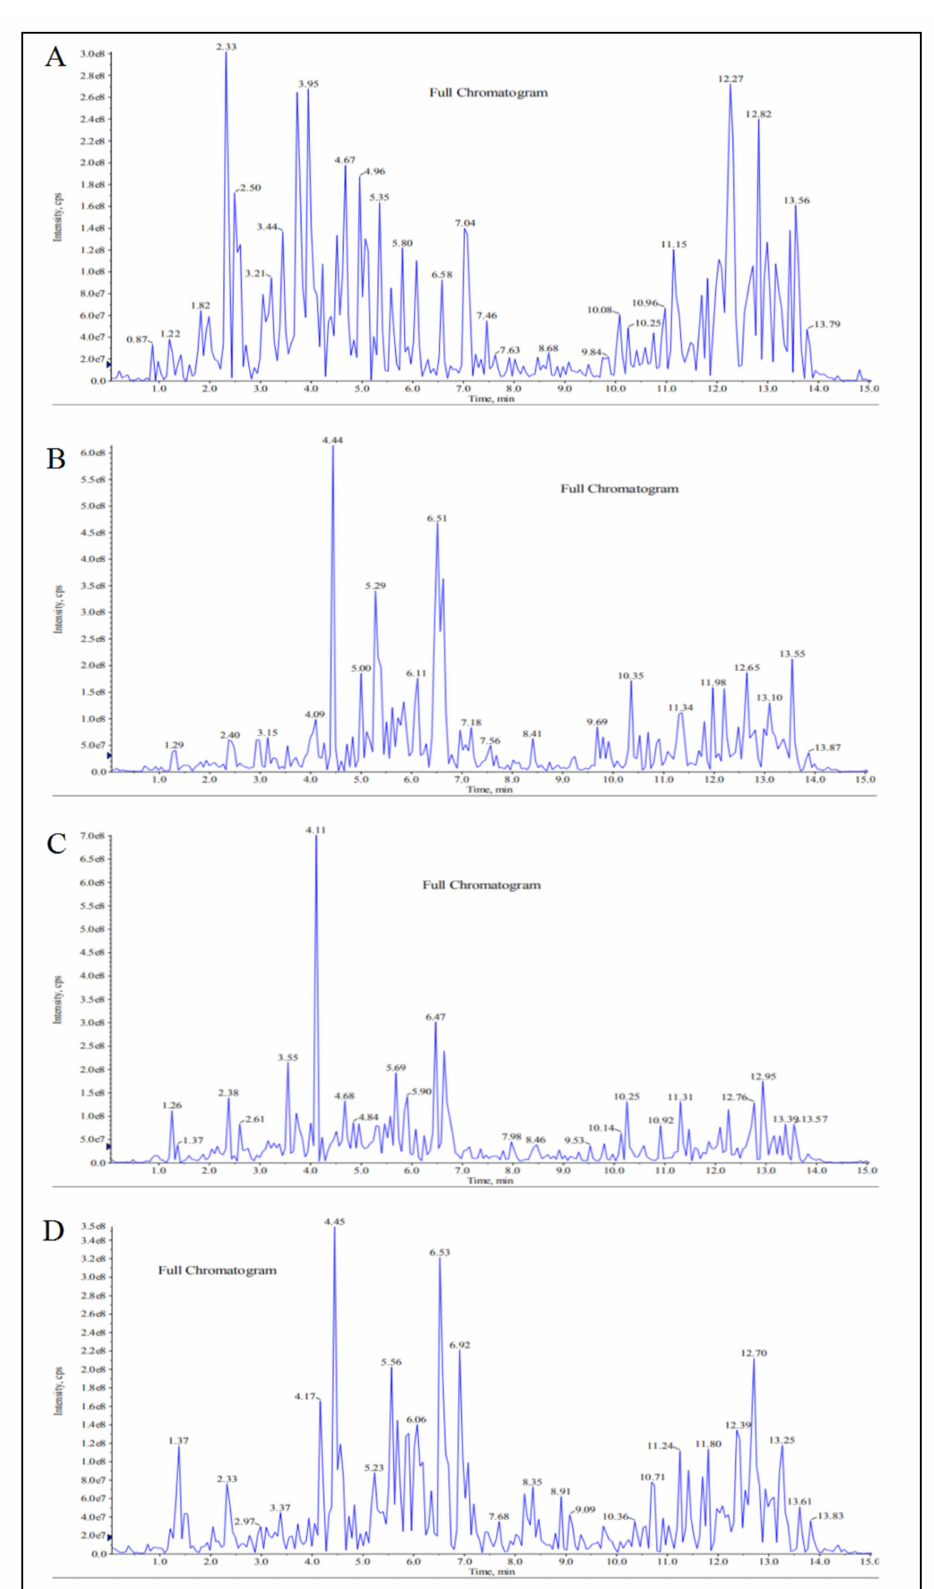
Figure 1. Liquid chromatography–tandem mass spectrometry (LC-MS/MS) chemical profiles of Marantodes pumilum (MP) aqueous extracts: ( A ) MP var. pumila (MPvp) leaves, ( B ) MPvp roots, ( C ) MP var. alata (MPva) leaves, and ( D ) MPva